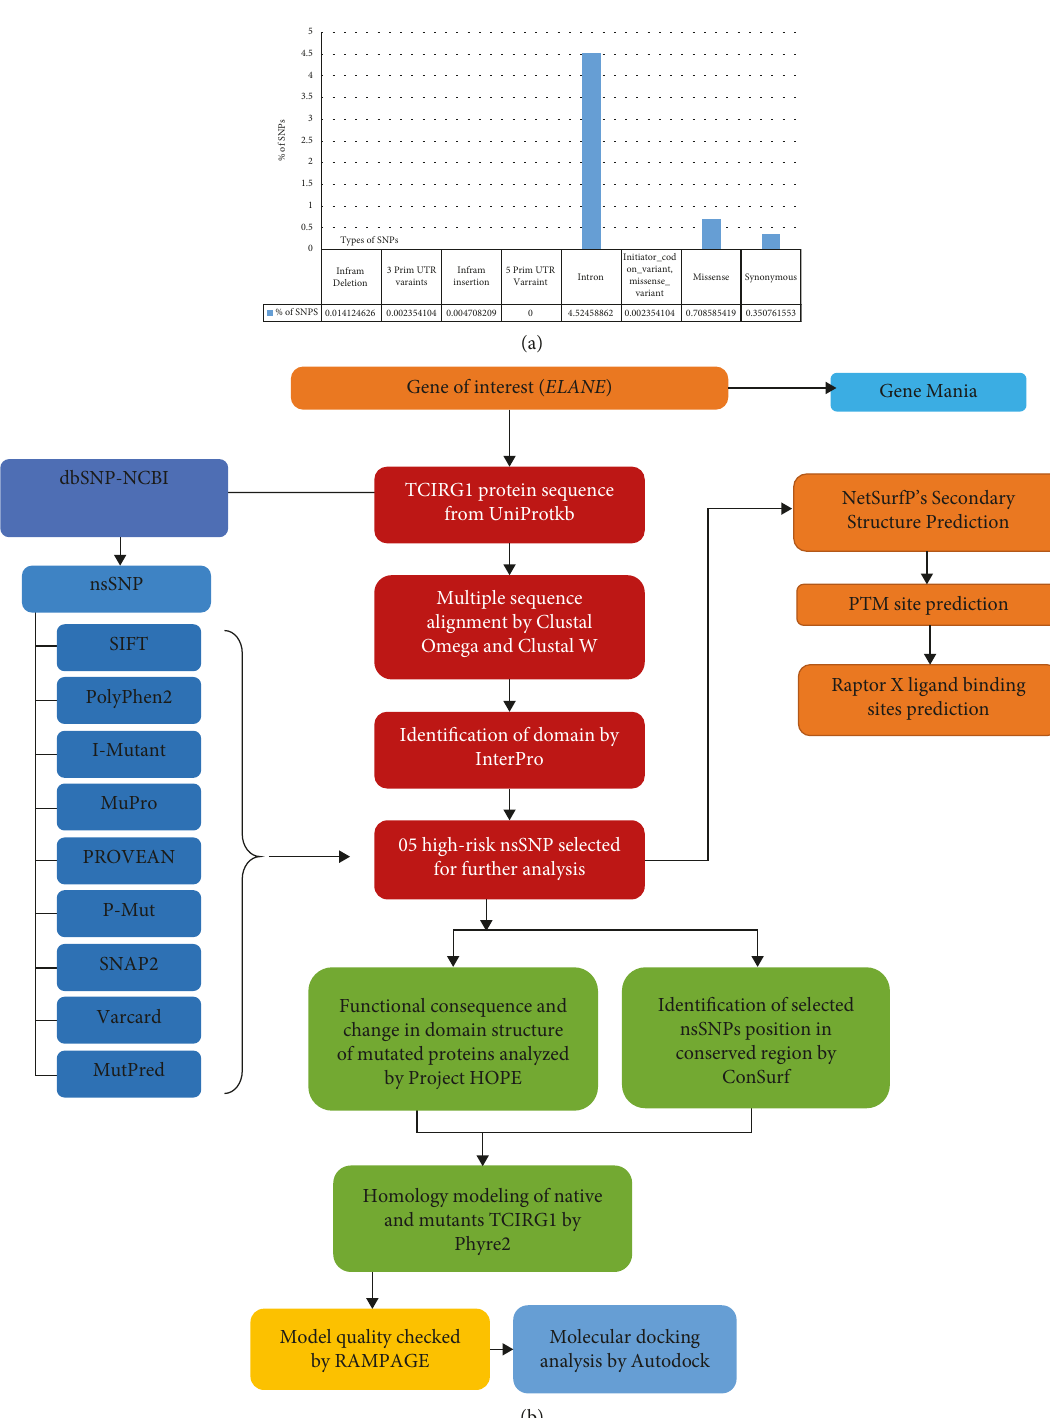
Figure 1: (a) Number of mutations reported in ELANE, extracted from the dbSNP database. (b) Flowchart for